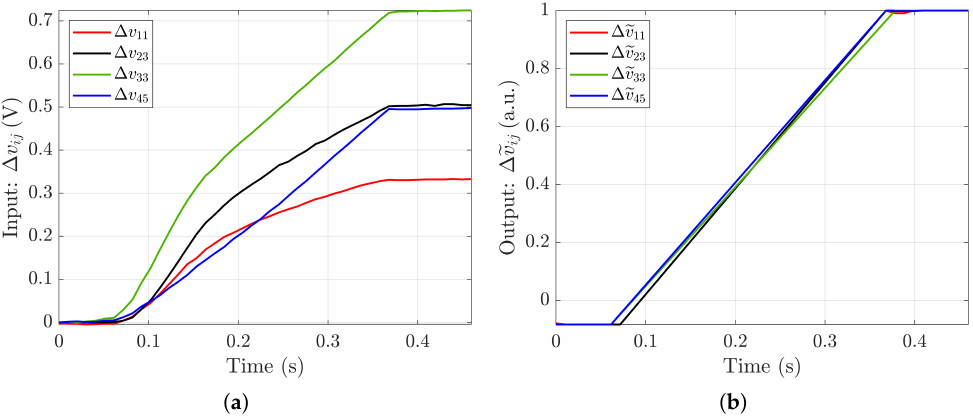
Figure 2. Responses of some taxels to the same stimulus (finger closure): voltage variation values directly acquired from the sensor ( a ) and the corresponding normalized values ( b